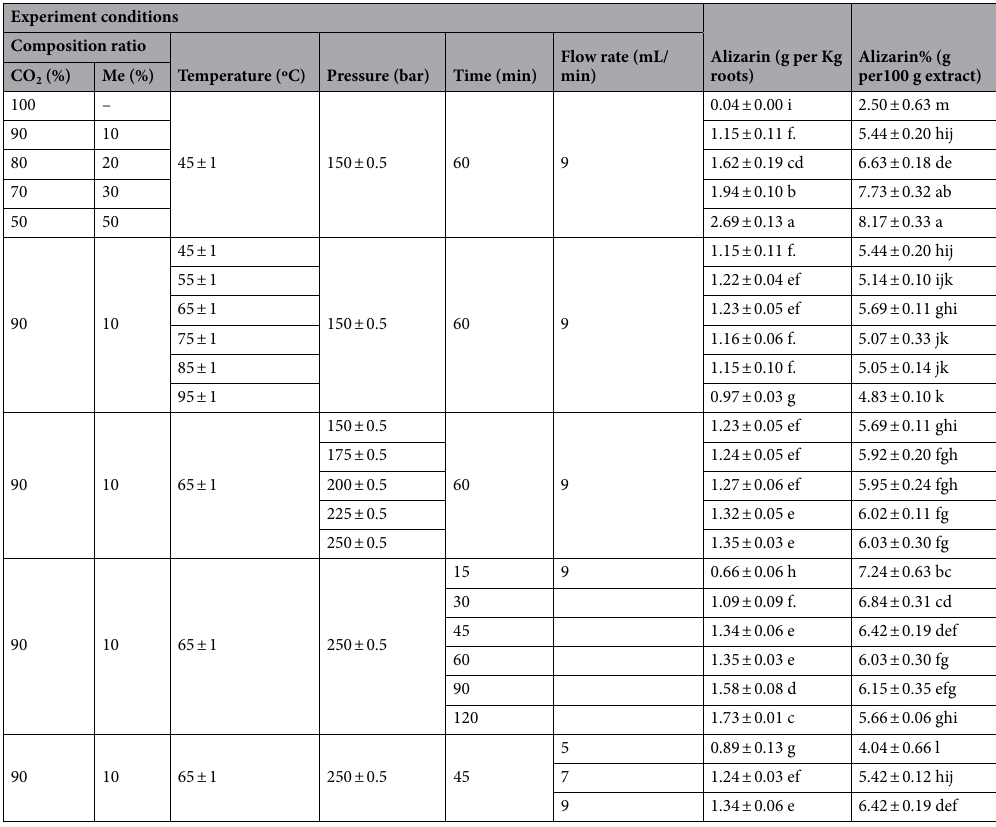
Table 1. The alizarin yield and statistical analysis of different SFE conditions ( a–m Means within a column followed by the same letter(s) are not significantly different according to Duncan’s multiple range test ( P =